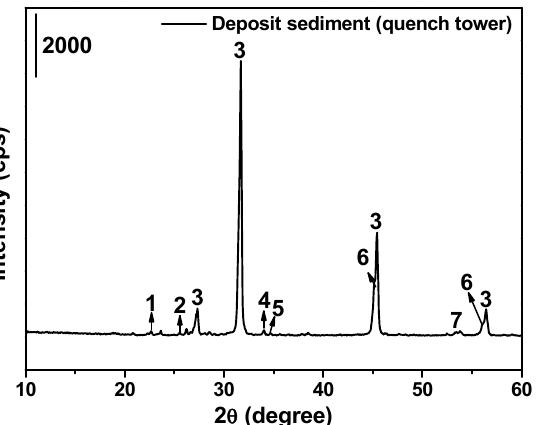
line phases can be shown as: (1) magnesium sulfate (MgSO 4 ), (2) aluminum sulfate (Al 2 (SO 4 ) 3 ), (3) halite (NaCl), (4) sodium sulfate (Na 2 SO 4 ), (5) sodium sulfite (Na 2 SO 3 ), (6) sodium bromide chloride (NaBr 0.1 Cl 0.9 ), (7) sodium bromide (NaBr).